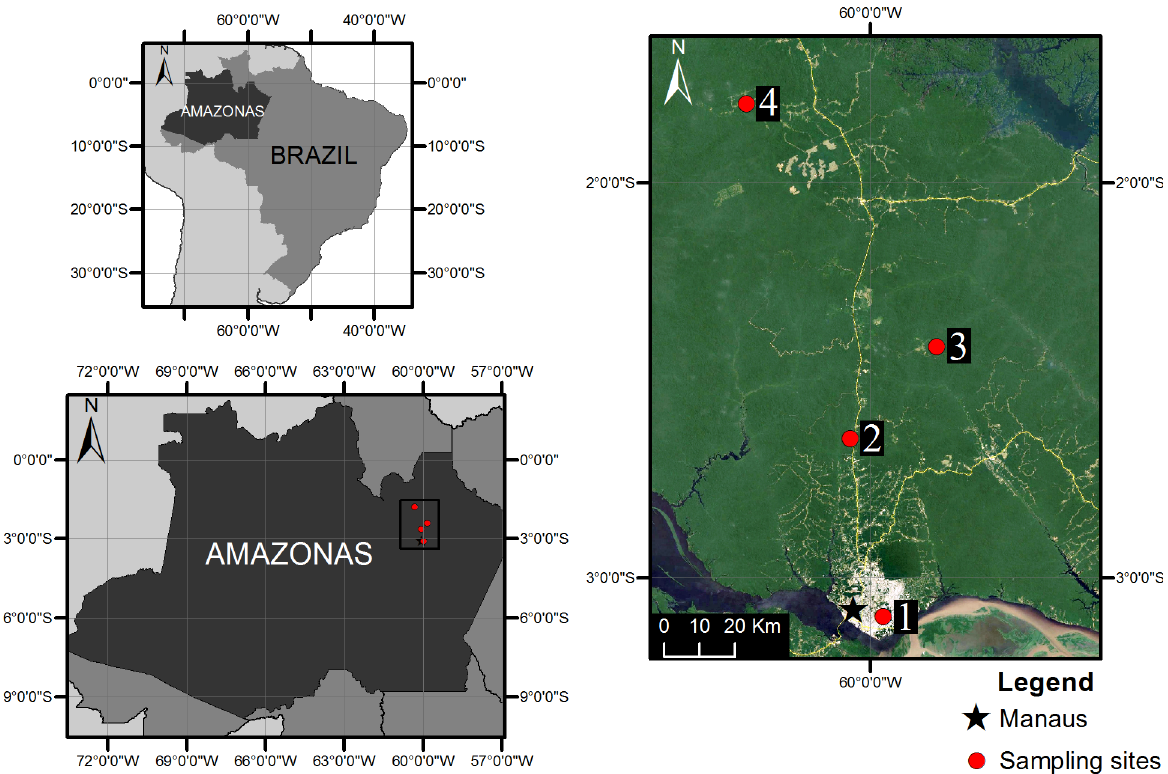
Figure 1. Sampling areas in Central Amazonia: (1) Campus of the Federal University of Amazonas (UFAM); (2) UFAM Experimental Farm; (3) Biological Dynamics of Forest Fragments Project (BDFFP) Reserve; (4) Agrovila Rio